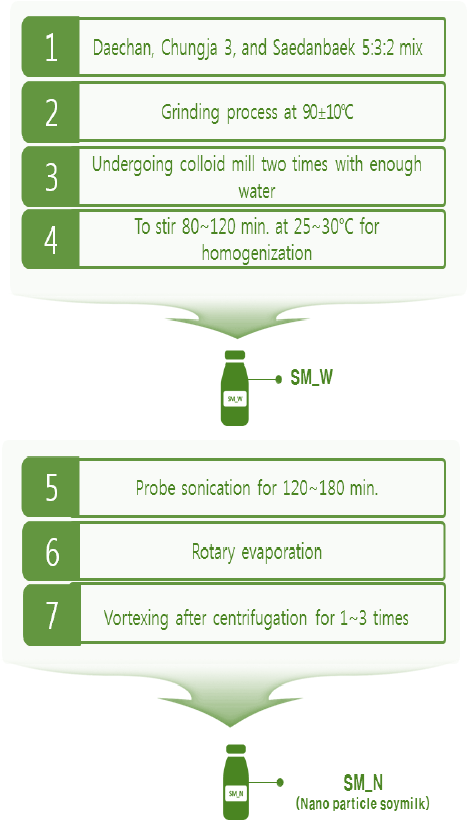
Figure 1. Laboratory soymilk production process.